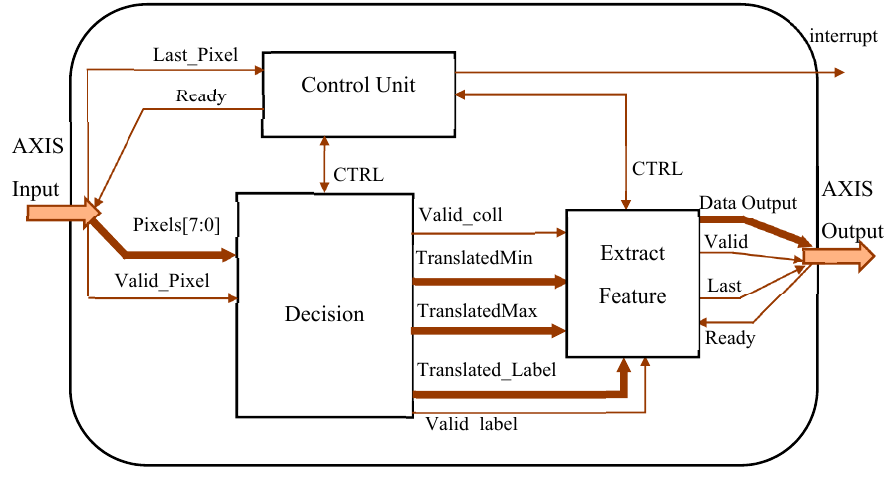
Figure 9. Top-level architecture of the proposed CCA accelerator.